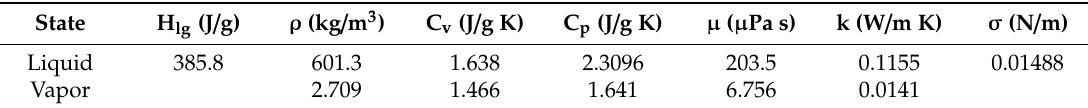
Table 2. Saturation properties of butane at atmospheric pressure ( − 0.49 ◦ C), from NIST Chemical Webbook Database